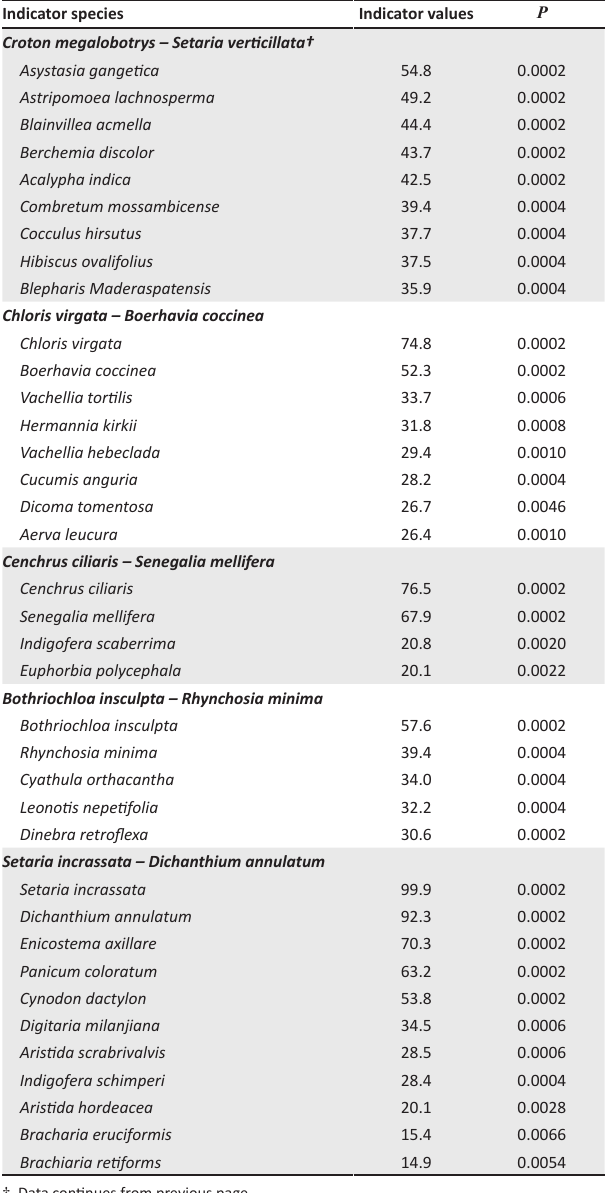
TABLE 2 (Continues...): Indicator species characteristics for 15 class divisions of plant communities in the Savuti-Mababe-Linyanti ecosystem (northern